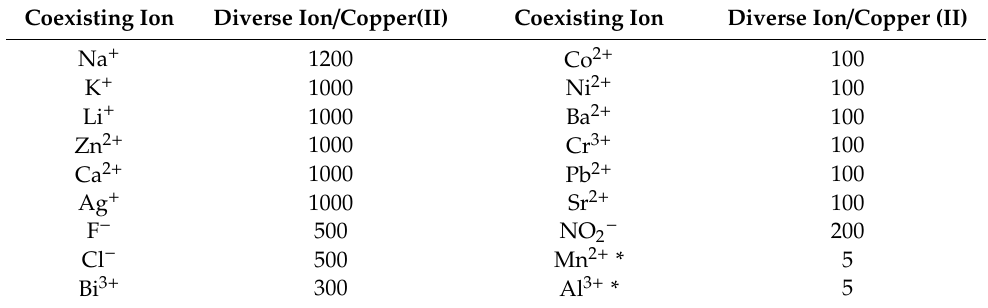
Table 3. Influence of some foreign ions when applying the developed spectrophotometric procedure for the estimation of 2 µ g mL − 1 Cu(II). [AMT] = 1.665 × 10 − 3 mol L − 1 ; relative error: ± 5%.